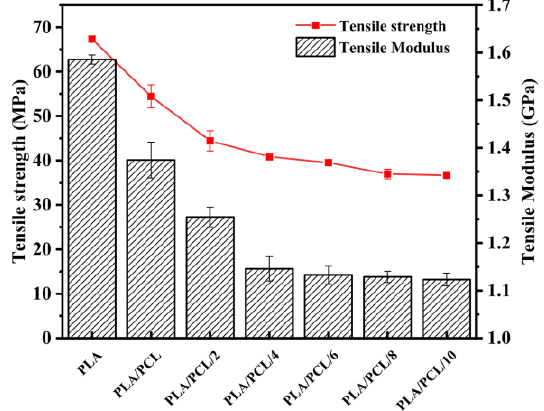
Figure 9. Tensile strength and tensile modulus of the neat PLA, PLA/PCL and PLA/PCL/EMA-GMA blends.